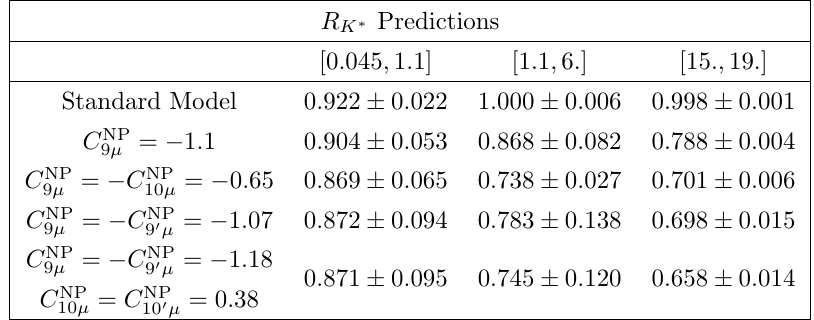
Table 9 . Predictions for R K (cid:3) = B